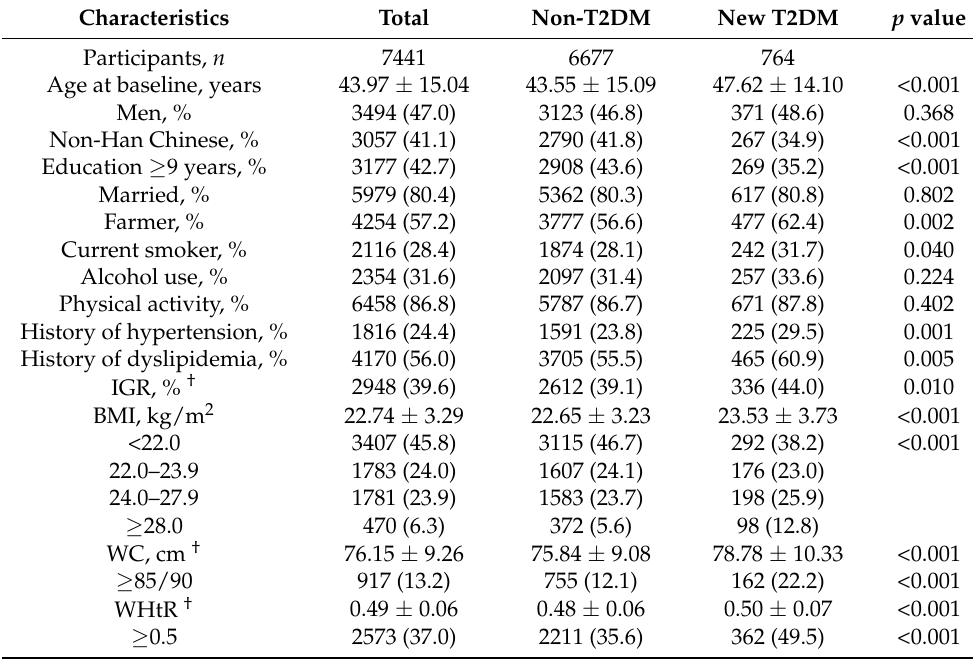
Table 1. General characteristics of the study population at baseline in Southwest